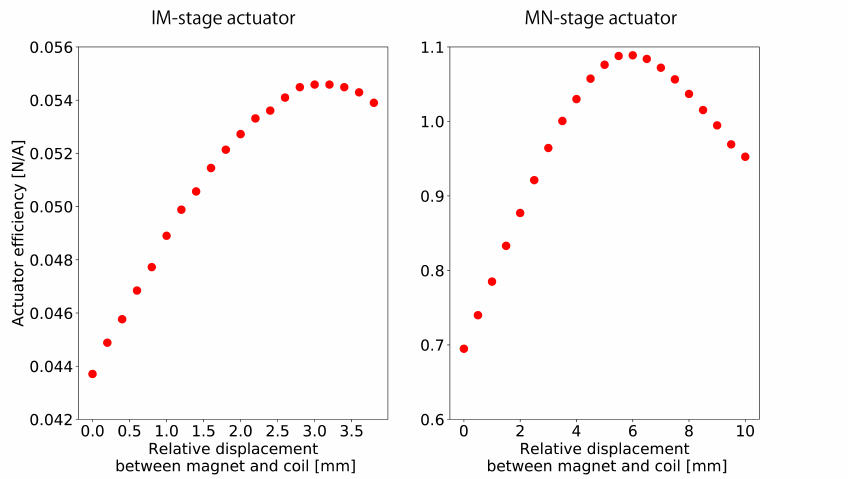
Figure 7. Actuator efficiencies of new coil–magnet actuators of the IM stage ( left ) and MN stage ( right ) as functions of the relative displacement between coils and